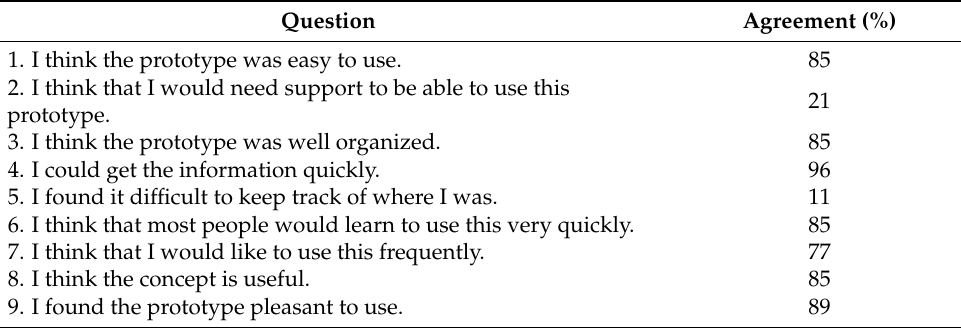
Table 7. SUS agreement rates from the four usability